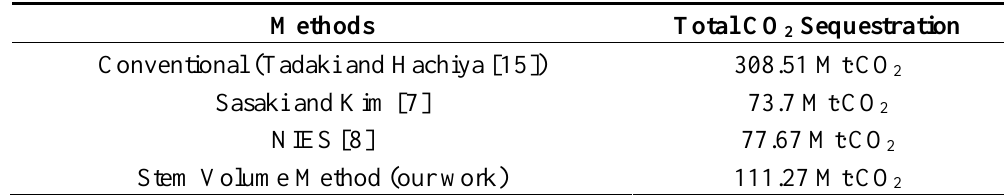
Table 8. Summary of the total CO 2 sequestration estimated by various methodologies in the different